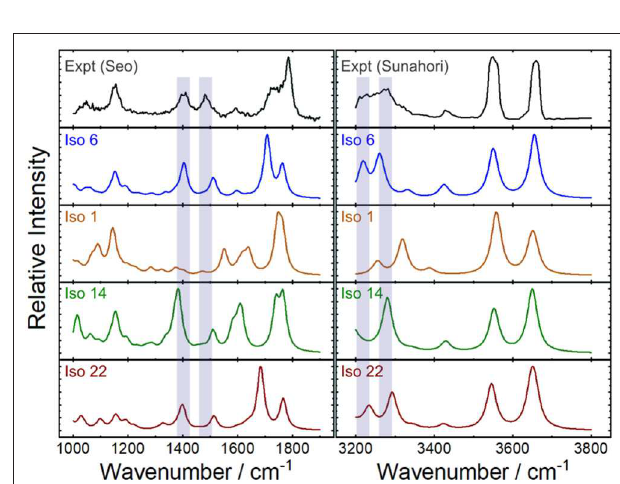
FIGURE 7 | Experimental IRMPD spectra and computed harmonic vibrational spectra for the protonated serine dimer. The experimental spectra were adapted from Seo et al. (2018) and Sunahori et al. (2013). The computed IR spectra are associated with the lowest energy isomer for each of the four binding motifs. Scaling factors of 0.9679 and 0.95 were employed for the 1,000–1,900 cm − 1 and 3,200–3,800 cm − 1 regions, respectively (Andersson and Uvdal, 2005; Fu and Hopkins,